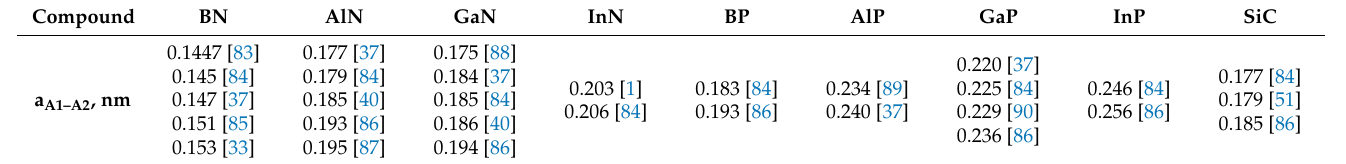
Table 1. Values of the bond length of hexagonal diatomic nanostructures available in the literature. Compound BN Figure 1. Representation of the hexagonal GaP lattice with designation of n and m, C h and θ . P atoms have a smaller radius and are represented in pale green and Ga atoms are in bright green. Considering the bond length, a A1–A2 , the N-CNT diameter, D n is defined as follows: